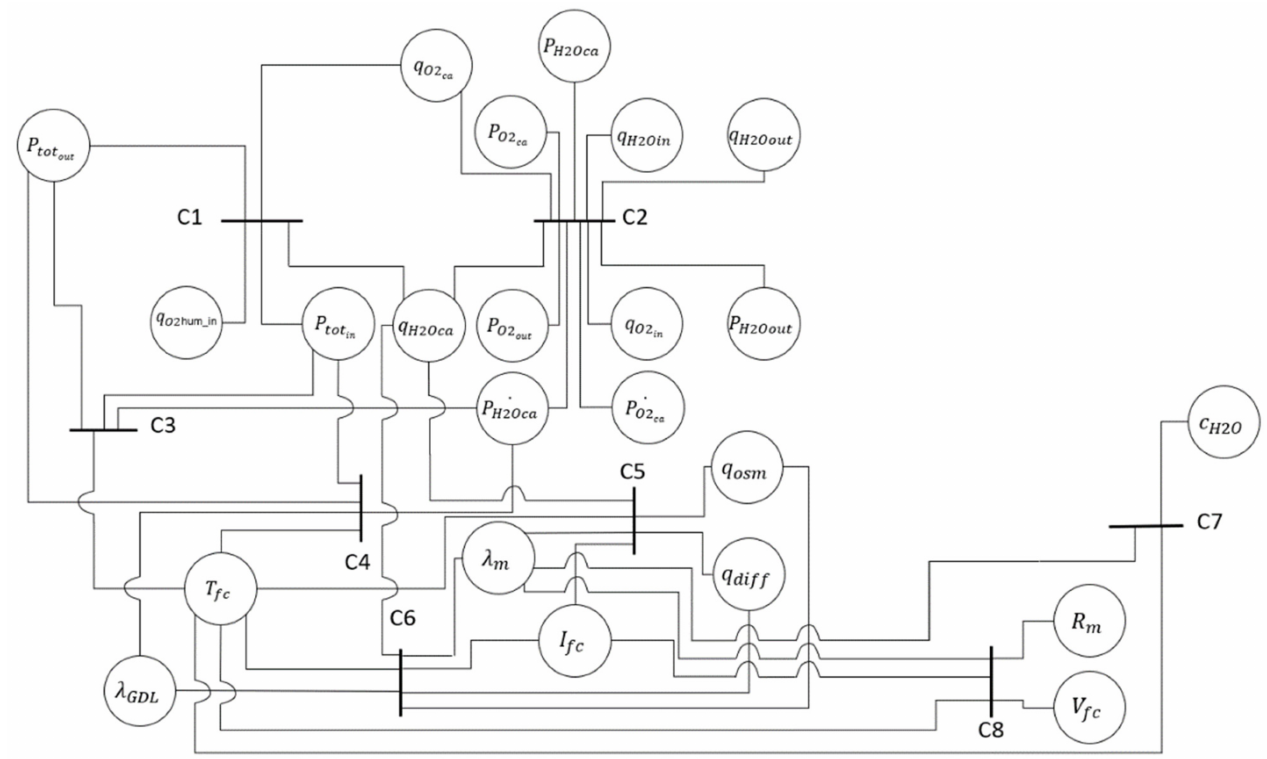
Figure 6. Structural graph of the